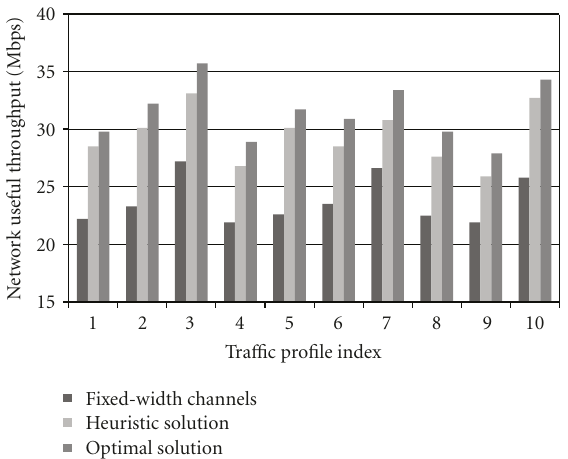
Figure 5: Comparison on the total useful throughput of the optimal solution and heuristic solution across 10 tra ffi c profiles.